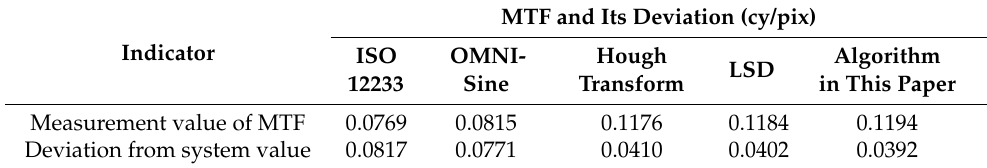
Table 2. MTF comparison at Nyquist frequency.